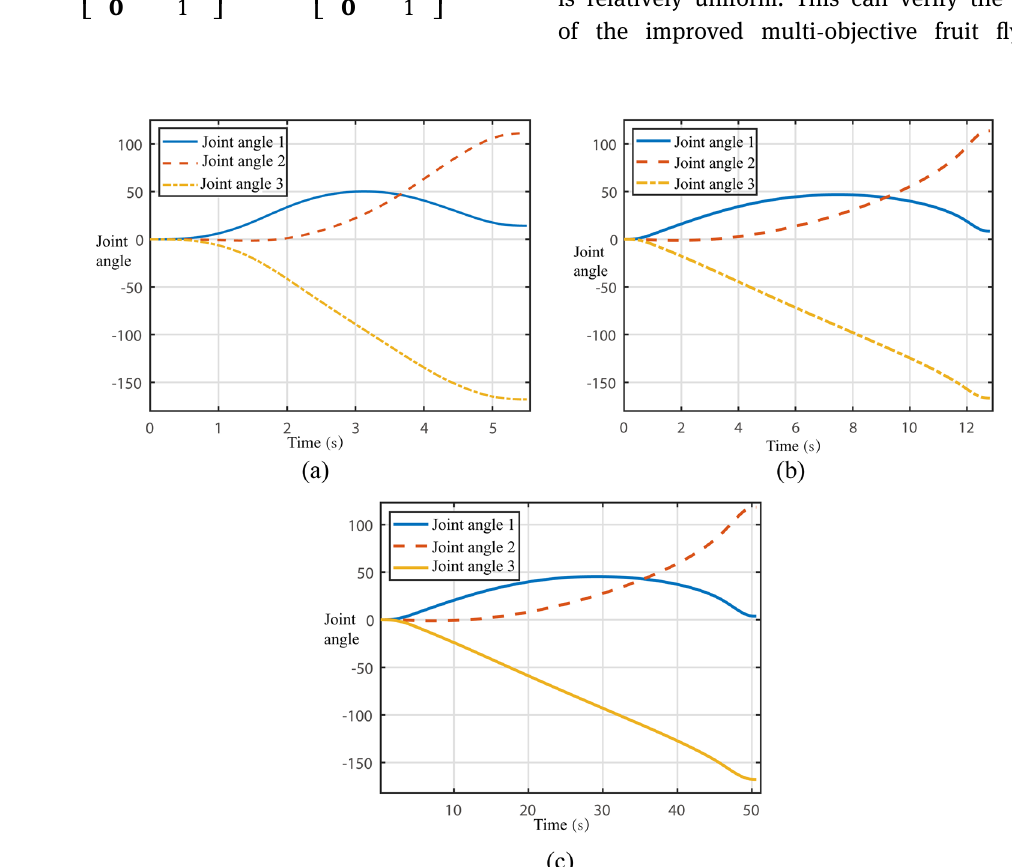
Figure 8: Joint angle curves under three conditions. ( a ) Condition A, ( b ) condition B, and ( c ) condition